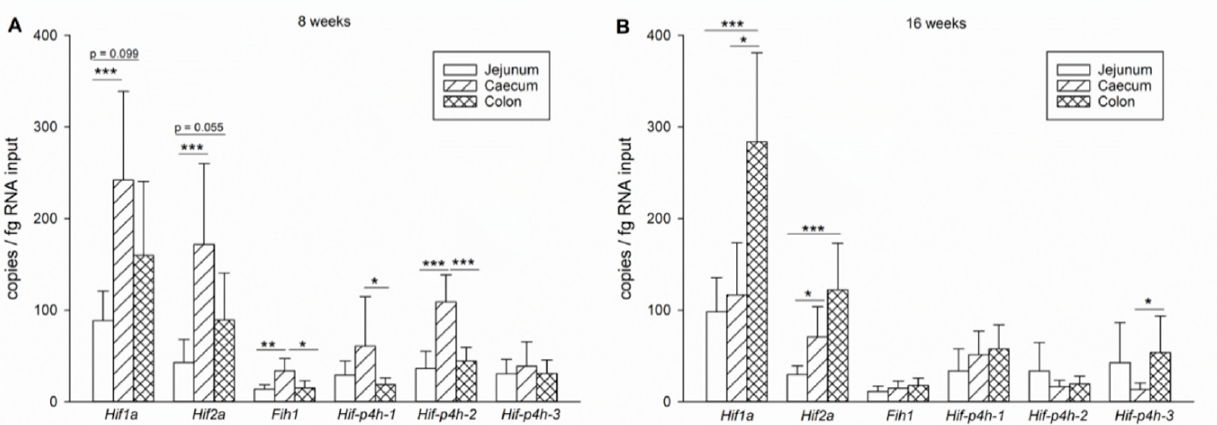
Figure 3. Comparative analysis of HIF pathway component expression in the small and large intestines. mRNA expression levels of Hif1a , Hif2a , Fih1 and Hif-p4h isoforms 1 , 2 and 3 in jejunum, caecum and colon epithelium of 8 ( A ) and 16 ( B ) -week-old wild-type mice. n = 14 for jejunum and 8 for caecum and colon epithelium; data are presented as means ± SD, One-Way RM ANOVA and subsequent Dunn’s test, asterisks indicate significant differences between locations, * p < 0.05, ** p < 0.01, *** p < 0.001.